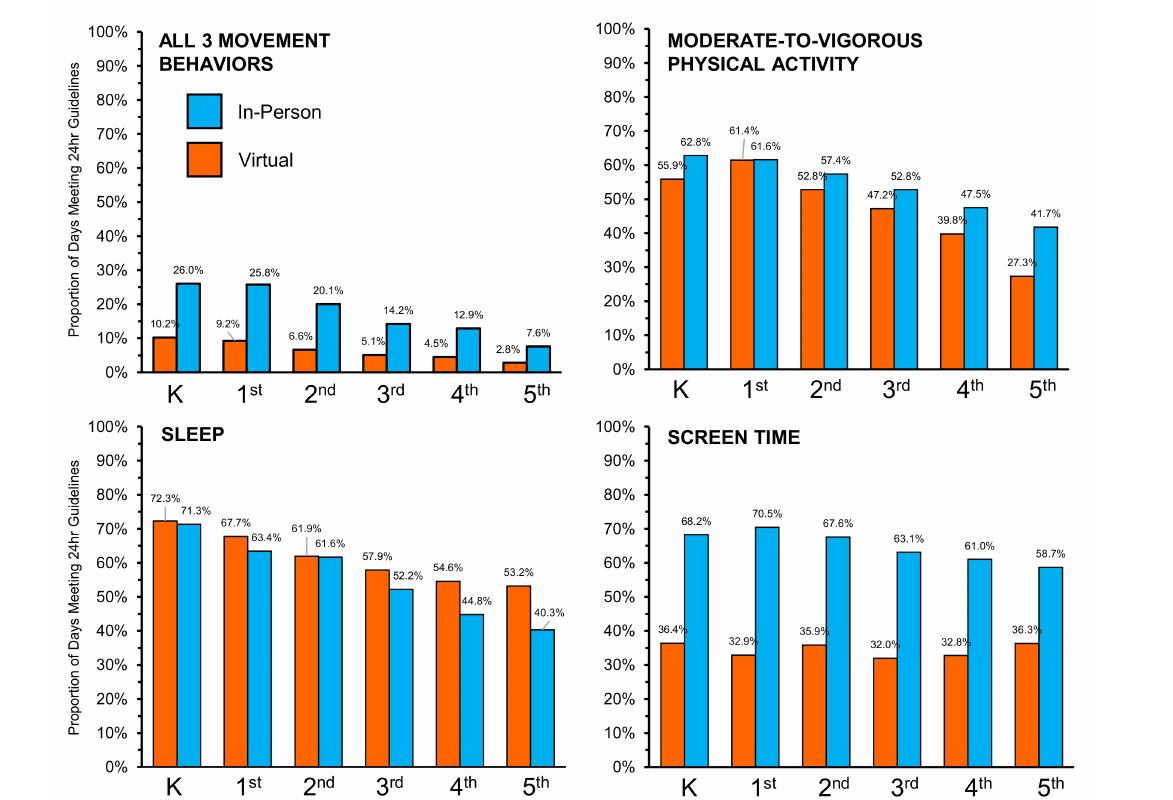
Figure 2. Proportion of days that the movement behavior guidelines were met during virtual (orange) and in-person (blue) school for elementary-age children during the same 14-day measurement period in October or November